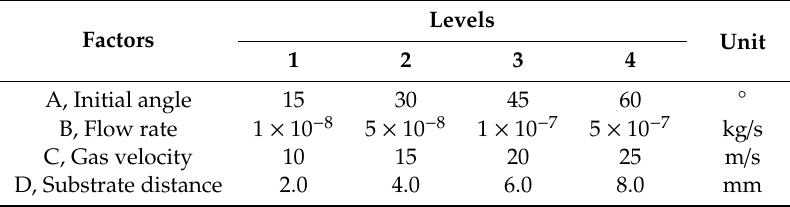
Table 1. Influencing factors of the uniformity for an orthogonal